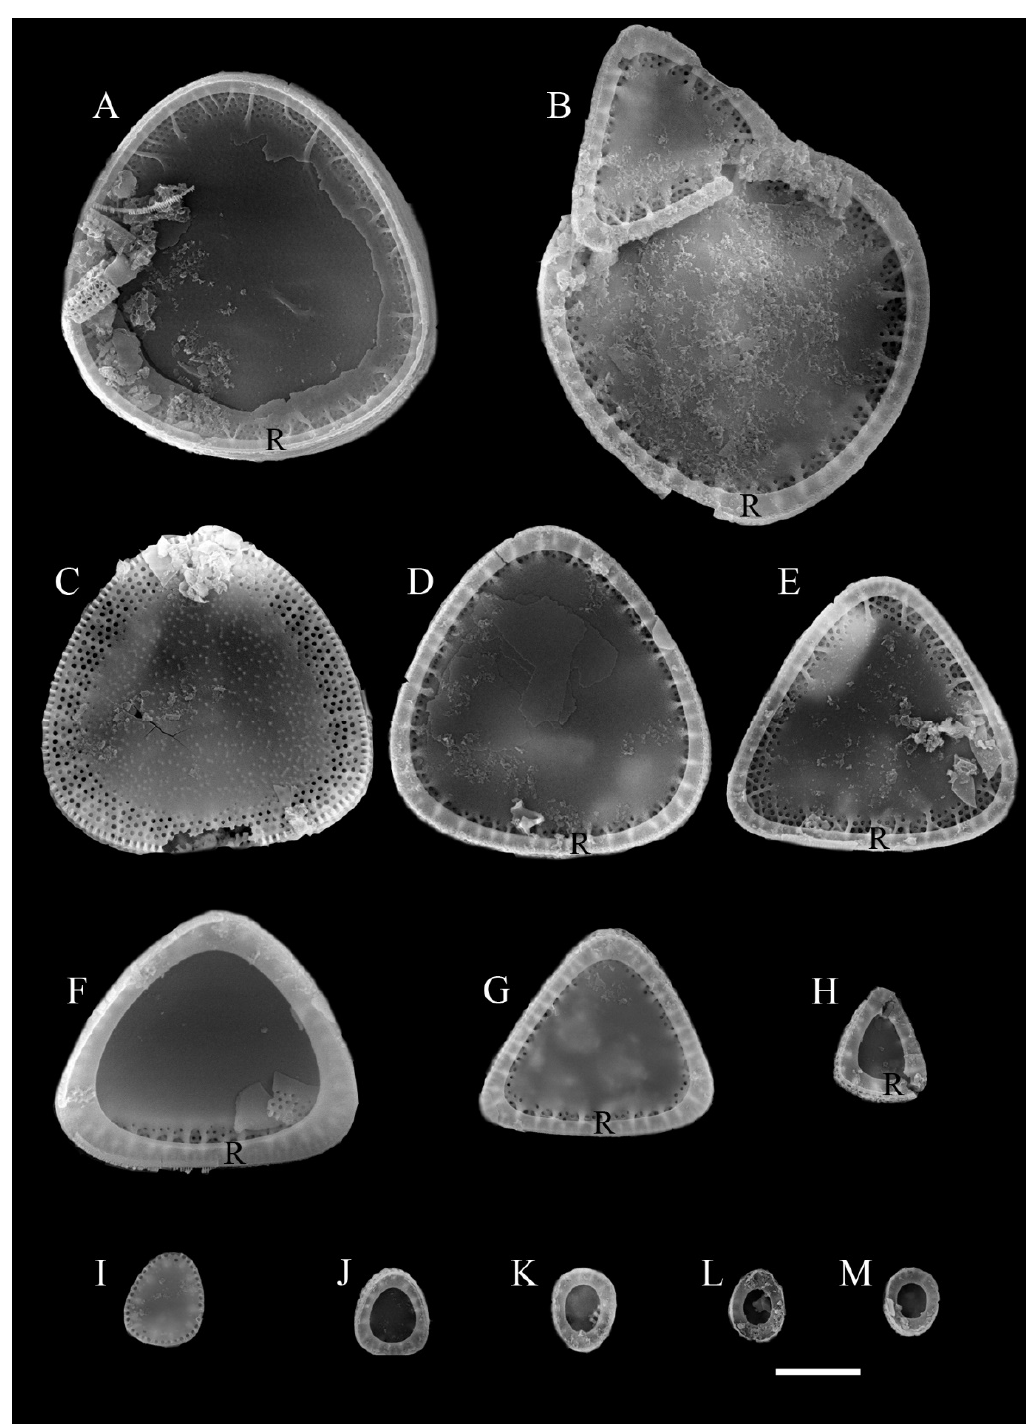
Figure 9. Alveolophora antiqua in the depth range of 54 to 53 m from core 517 of the Barguzin Valley: ( A , B , D – M )—internal views showing a ringleist (R), variability of valves and aperture of ringleist in their shape; ( C )—external view of the valve face. SEM. Scale bar: 10 µm.